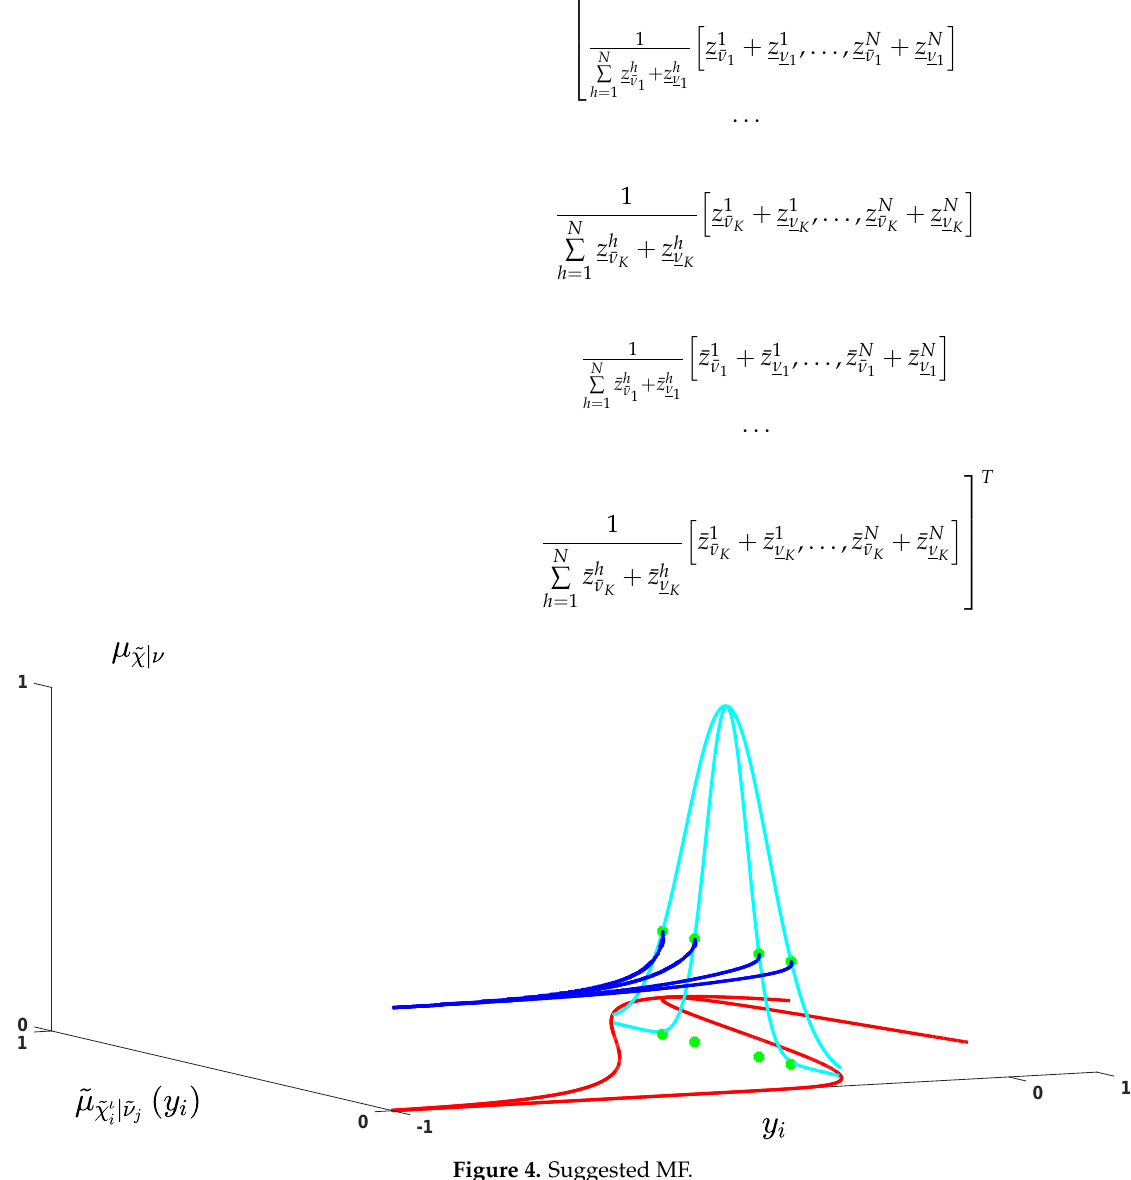
Figure 4. Suggested